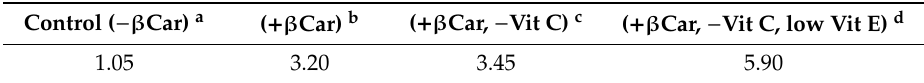
Table 2. Influence of varying levels of vitamins C and E on β -carotene-modulated tumor multiplicity (average number of tumors per animal at median tumor